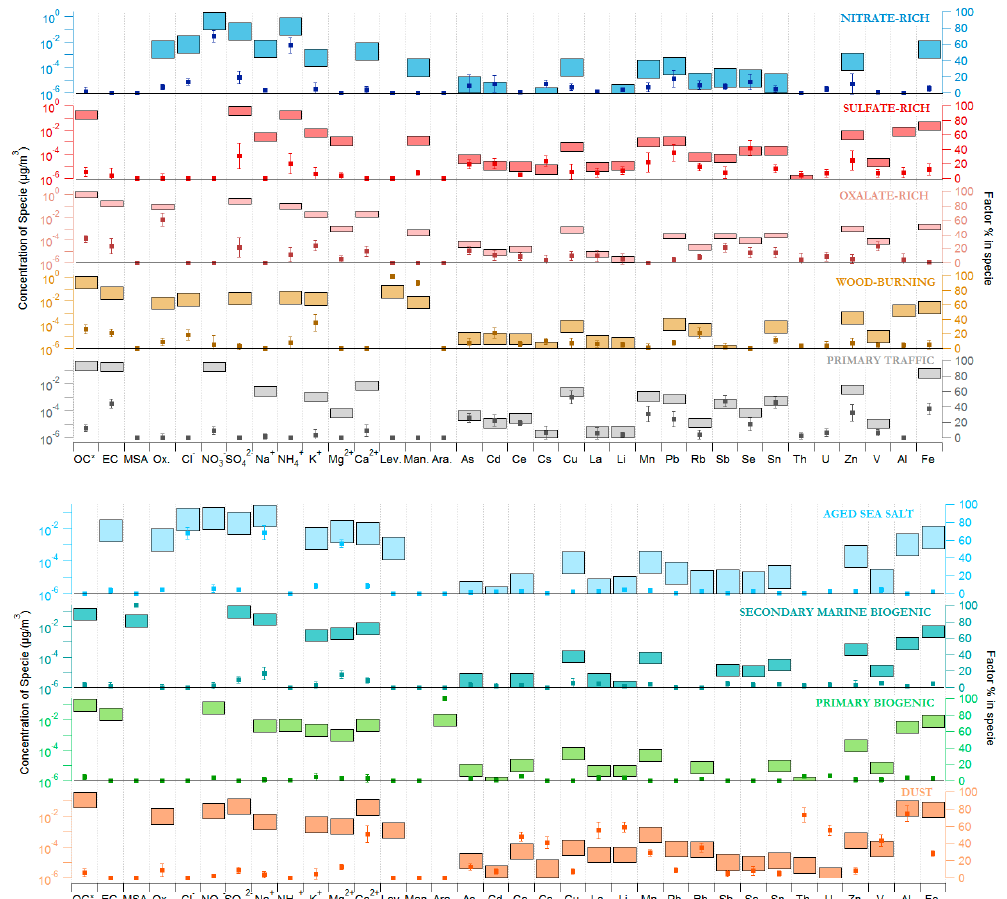
Figure 1. Chemical profiles of the PMF (Positive Matrix Factorization) factors obtained from the constrained bootstrap analysis. Bars (left axis) correspond to the InterQuartile Range (defined as p 25 and p 75 ) of concentration values in the profile; markers with error sticks correspond to the median (±IQR) of factor percentage in each specie.